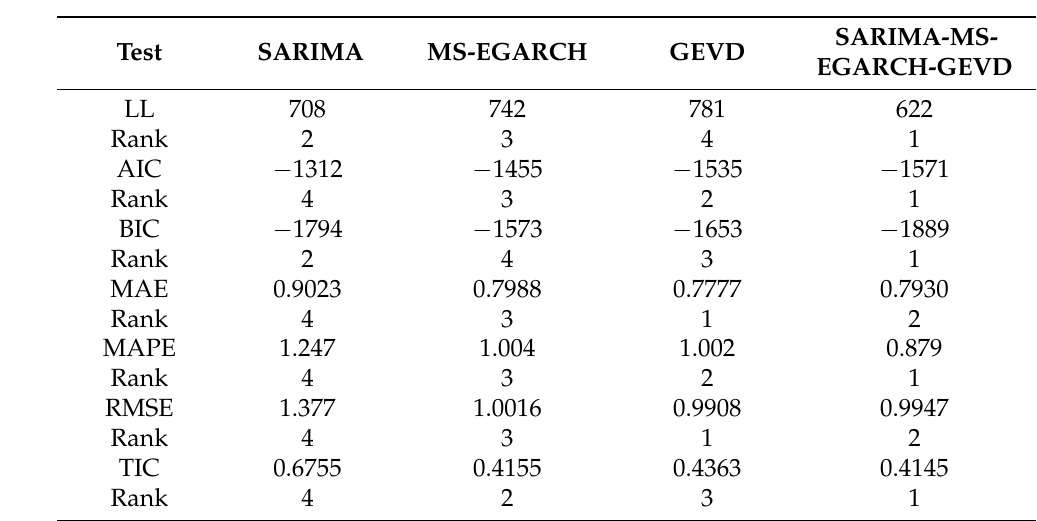
Table 4. Comparative Analysis.